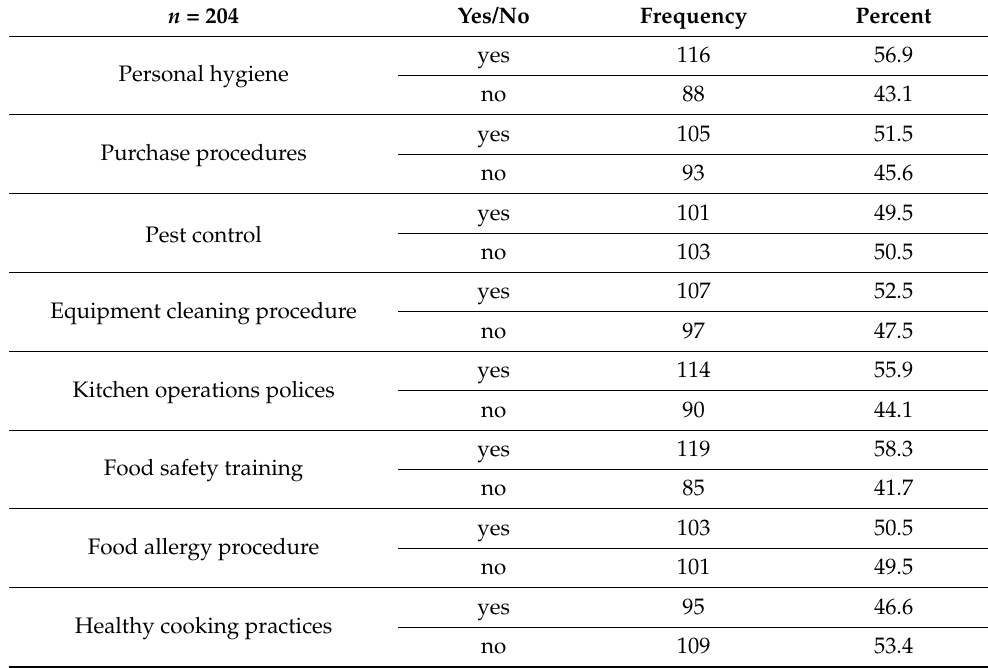
Table 3. Types of training under taken by food handlers in Kenyan secondary school